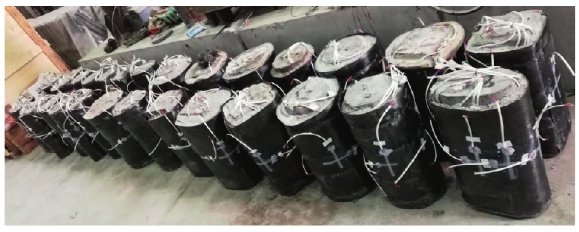
Figure 2: Molded test piece. Table 2: Proportions of ingredients used for concrete mix.